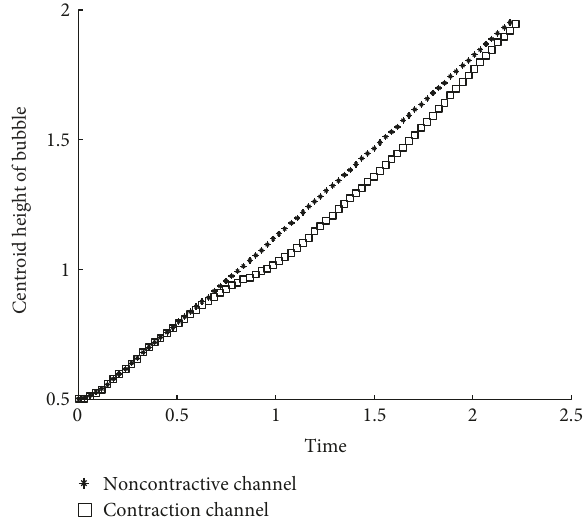
Figure 8: The centroid height of the bubble in the contractive and noncontractive channels (Re =70, Mo=8 × 10 − 5 , and Eo=8).